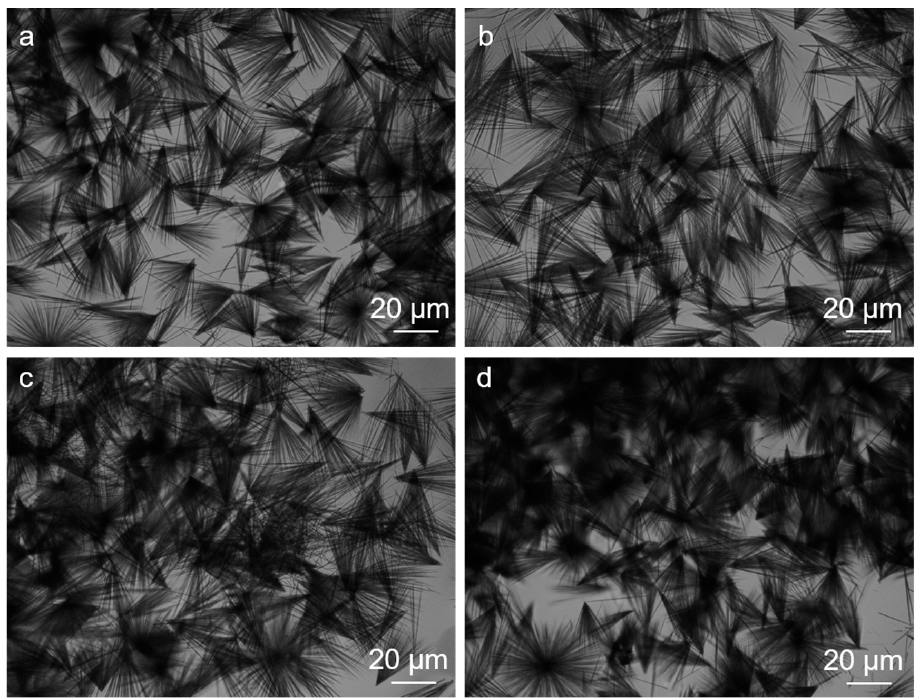
Figure 3. The images of the FF/NaC mixtures at a NaC concentration of 8 mmol/L with FF concen- trations of ( a ) 30, ( b ) 40, ( c ) 50, and ( d ) 60 mmol/L, as given by optical microscopy.